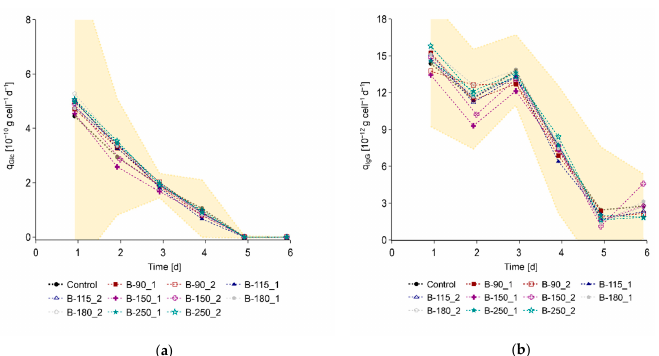
Figure A2. Course of ( a ) glucose consumption rate, and ( b ) IgG production rate during the batch experiments inoculated directly from cryovials containing high VCDs from 90 to 250 × 10 6 cells mL − 1 (nomenclature: B = Batch, 90/115/150/180/250 = VCD in cryovial (×10 6 cells mL − 1 )). Control: batch experiments inoculated directly from cryovials containing lower VCDs (15–40 × 10 6 cells mL − 1 , n = 3).